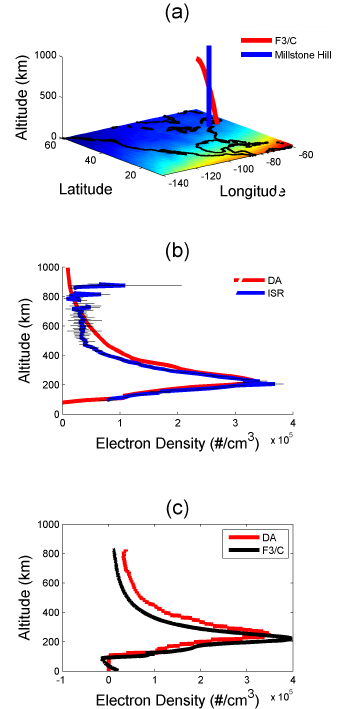
Figure 7. The comparison of the data assimilation results, Millstone Hill incoherent scatter radar observation, and F3/C electron density profile from the Abel inversion. (a) The location of F3/C RO tangent point electron density profile (red) and the location of Millstone Hill observation electron density profile (blue). (b) The electron density profile of DA (red), ISR (blue), and ISR’s error bars (black) over Millstone Hill. (c) The electron density profile of DA (red) and F3/C (black) along the RO tangent